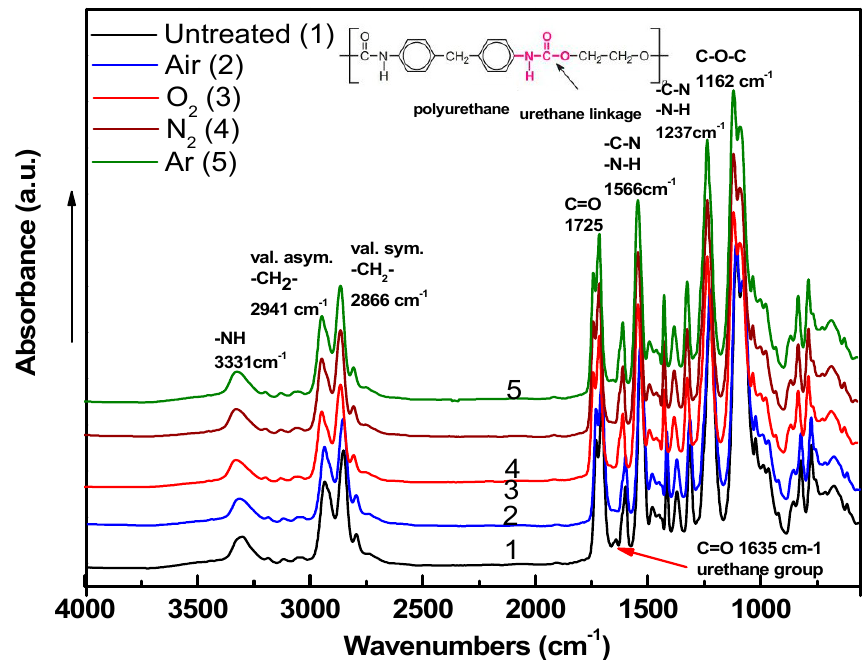
Figure 9. FTIR spectra of plasma-treated PU using different gases.